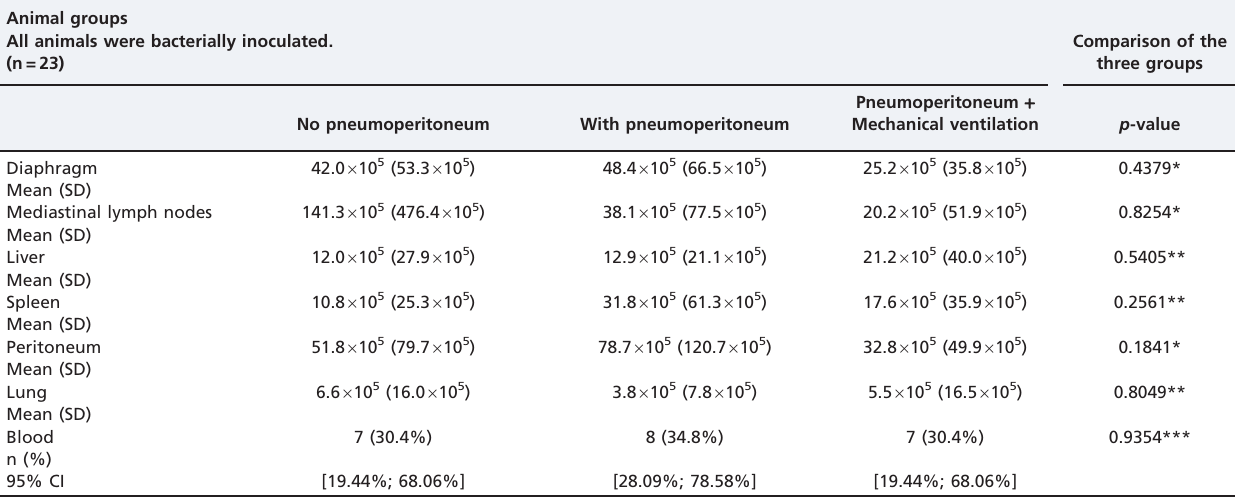
Table 1 - Comparison of the blood (qualitative) and other tissue (quantitative) culture results between the three groups. Animal groups All animals were bacterially inoculated.